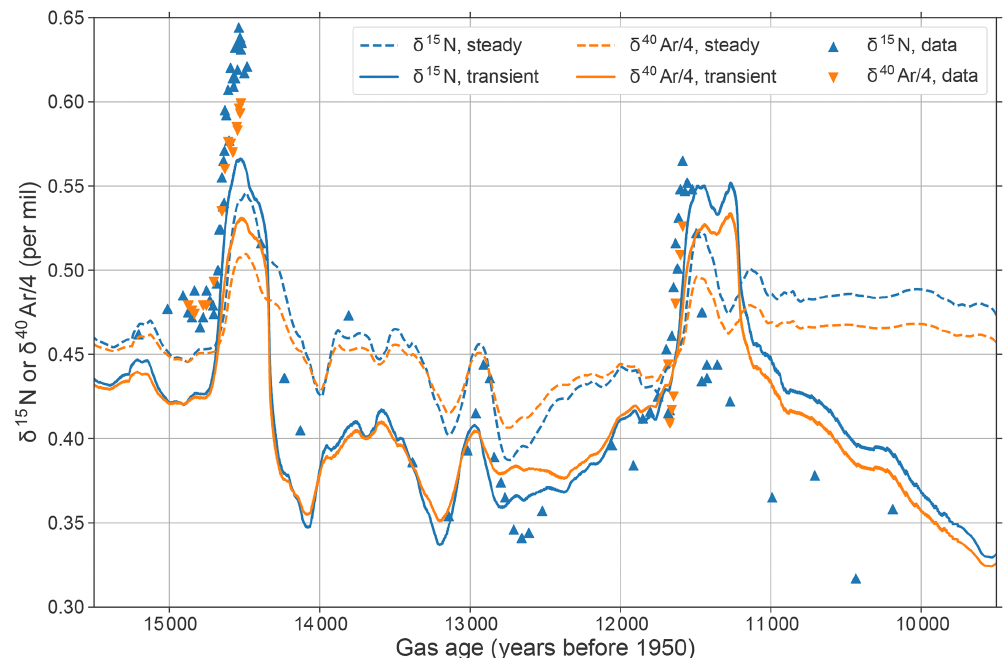
Figure 4. Measured and modeled δ 15 N and δ 40 Ar / 4 profiles. Data are from Severinghaus et al. (1998) and Severinghaus and Brook (1999). We add 1.5% to the modeled gas ages to fit the